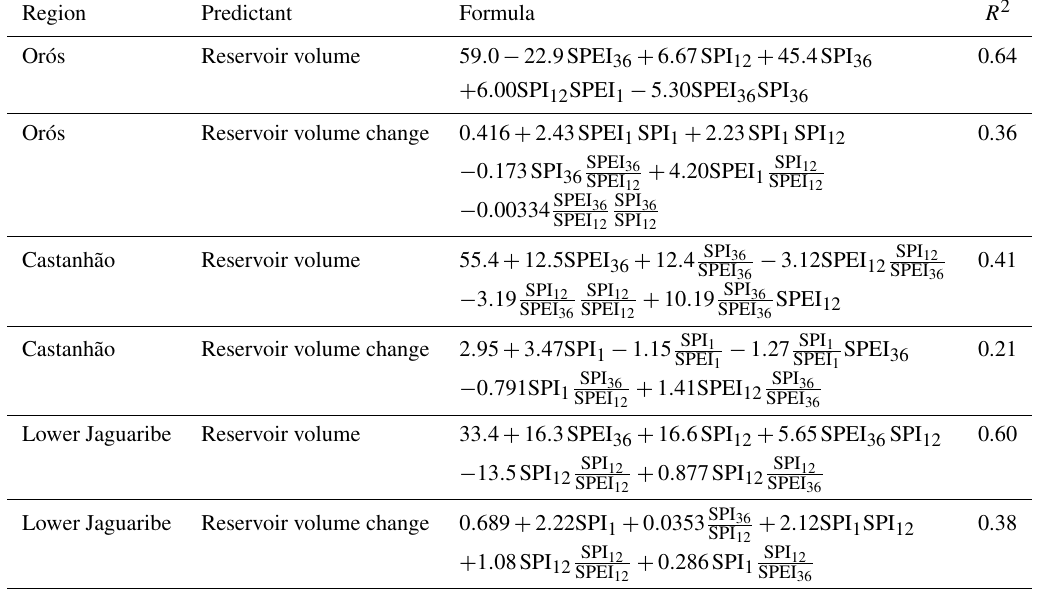
Table A1. Regression used for predicting regional reservoir volume and regional reservoir volume change using a set of MDIs as predictors. Regional reservoir volume was taken at the end of each month relative to the total regional reservoir storage capacity. Regional reservoir volume change refers to the difference between the given and previous